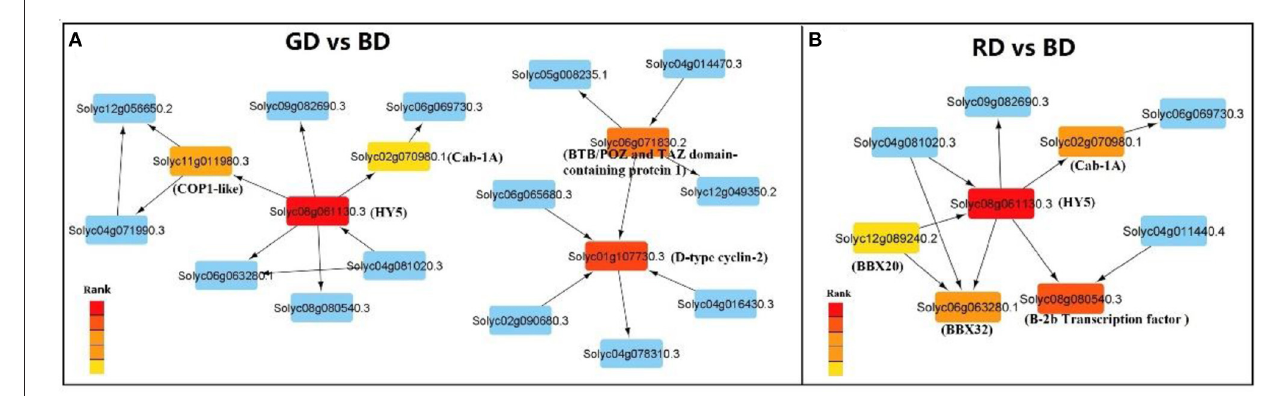
FIGURE 7 | Protein-protein interaction (PPI) network analysis based on the DEDs in the comparisons of “GD vs. BD” (A) and “RD vs. BD” (B) . Nodes depict proteins encoded by related genes and PPI are represented by edges in the network; the top five hub DEDs encoded proteins are represented by various colors (red: high rank; Yellow: low rank) in the PPI